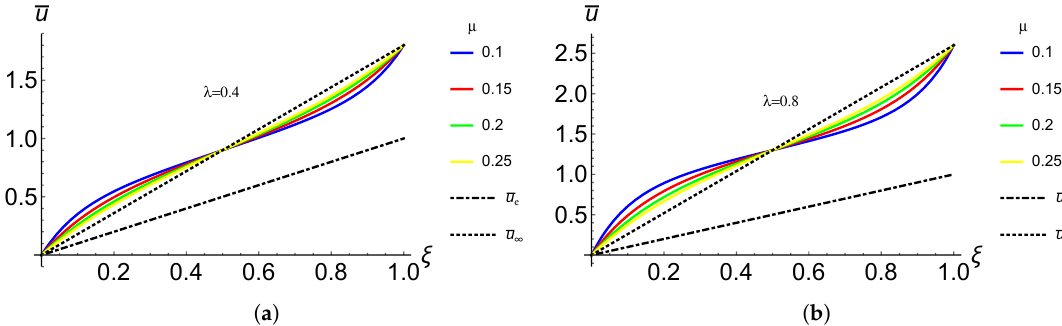
Figure 1. CF nano-rod with a concentrated load at the free end. Plot of the non-dimensional axial displacement ¯ u , limit non-dimensional axial displacement ¯ u ∞ (black dotted line) and local non-dimensional axial displacement ¯ u e (black dot dashed line) vs. the non-dimensional nano-rod axis for the gradient non-dimensional parameter µ in the set { 0.10,0.15,0.20,0.25 } and: ( a ) nonlocal non-dimensional parameter λ = 0.4; and ( b ) nonlocal non-dimensional parameter λ = 0.8. The 3D plot of the non-dimensional maximum axial displacement ¯ u ( 1 ) for the proposed NSG method versus the non-dimensional characteristic parameters λ and µ is reported in Figure 3. The horizontal plane is the non-dimensional local maximum axial displacement ¯ u e ( 1 ) =